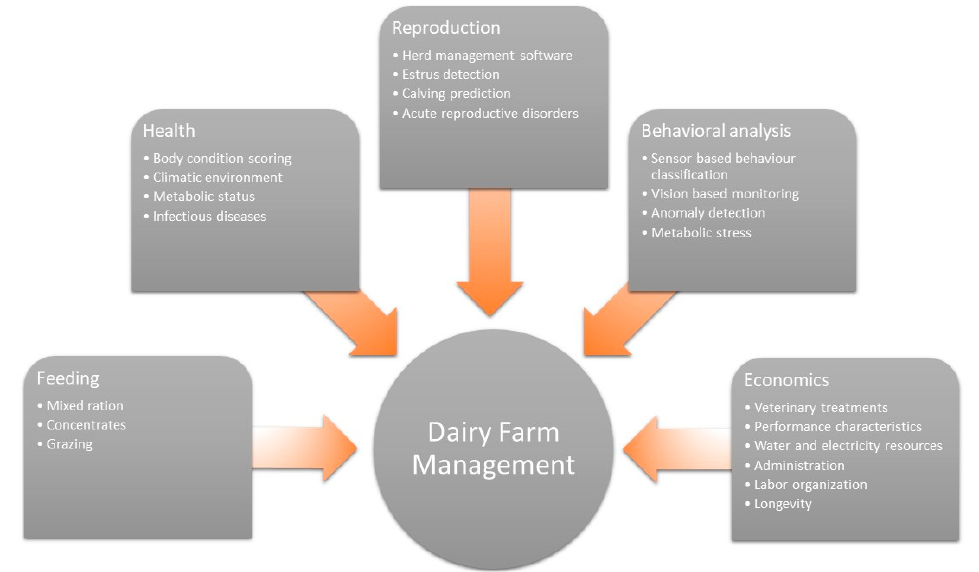
Figure 1. Systematic structure of dairy farm management.